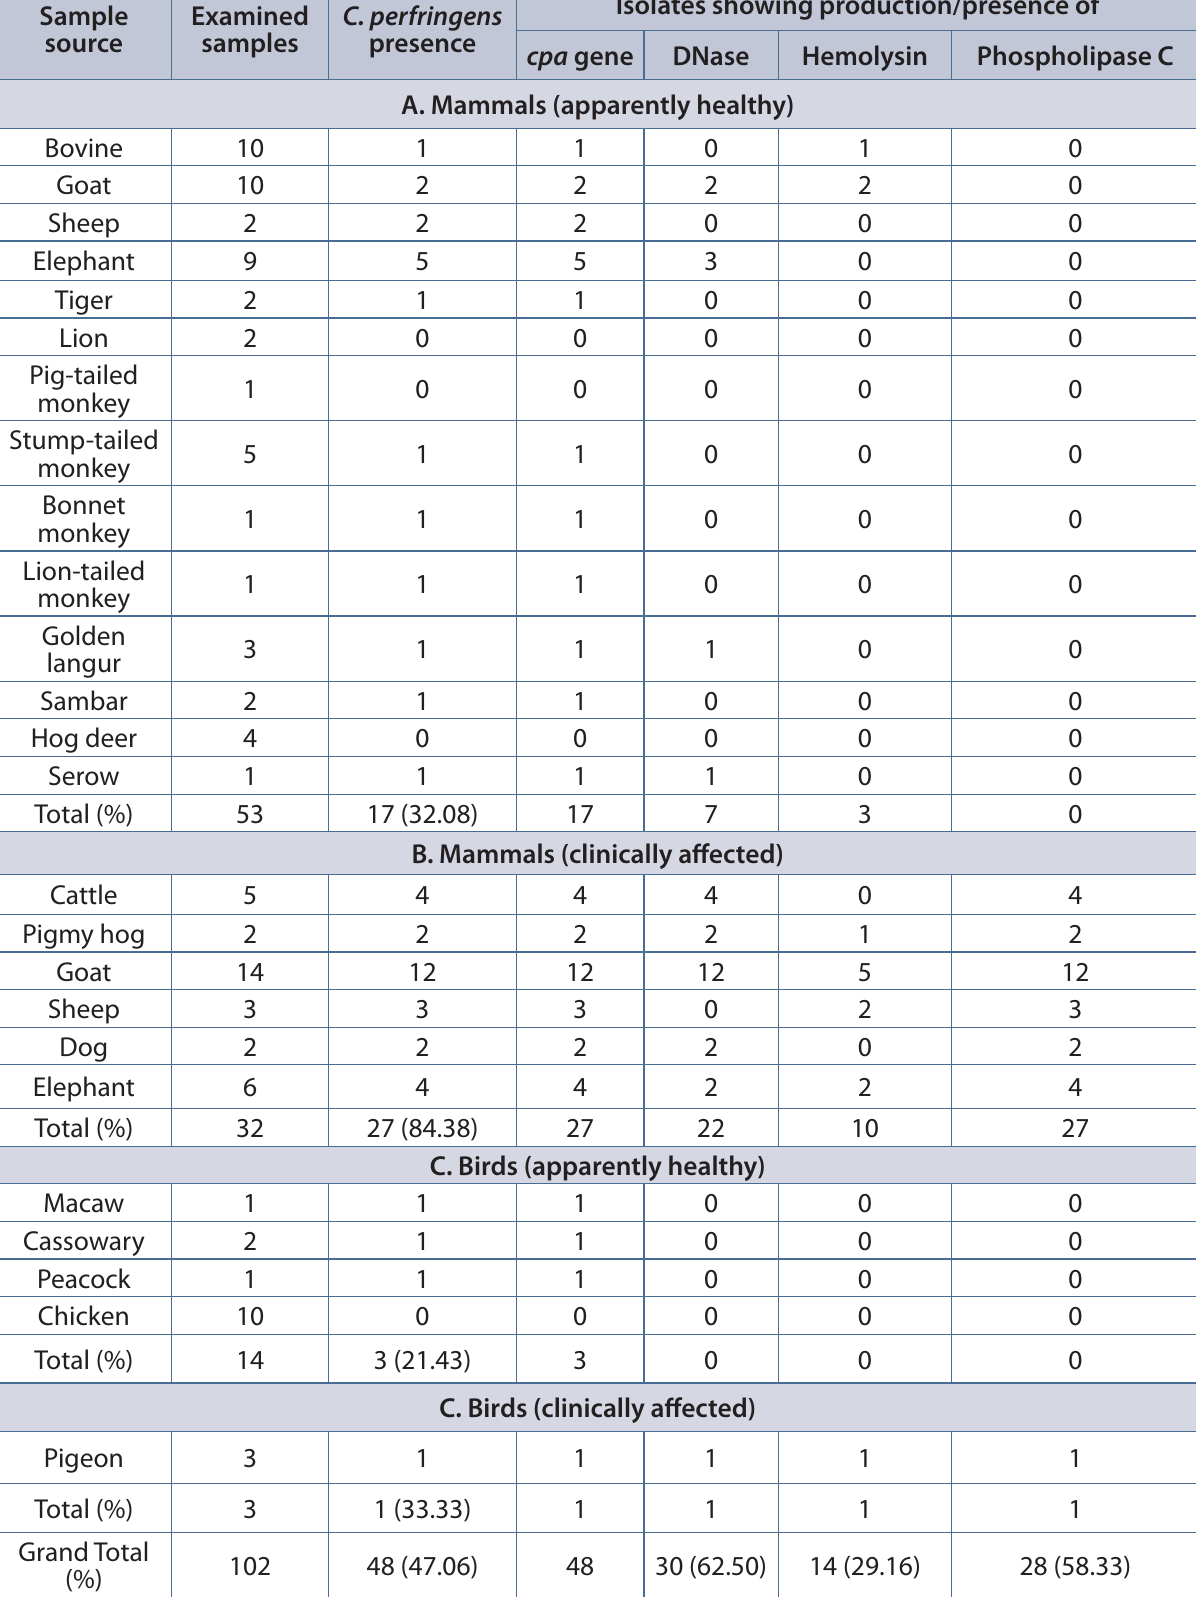
Table 1. Prevalence and characterization of Clostridium perfringens of mammal and bird origin in relation to deoxyribonuclease (DNase), hemolysin, phospholipase C production and presence of cpa gene in Guwahati city during 2009 and